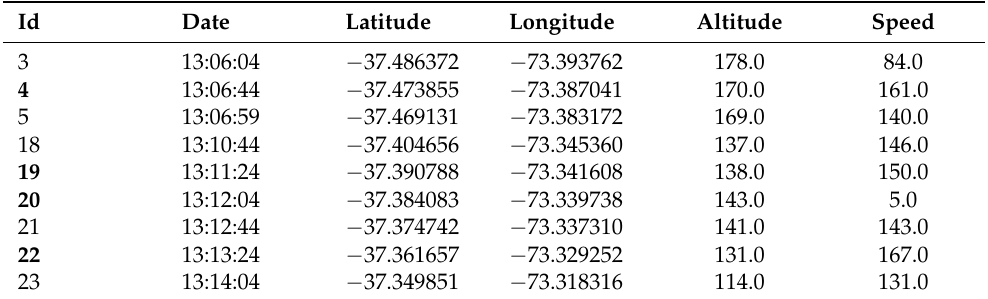
Table 11. Detail of GPS measurements with the greatest error, including contiguous ones, of the trajectory of Figure 8. The measurements that contribute the most to the trajectory error are indicated in boldface in Id.